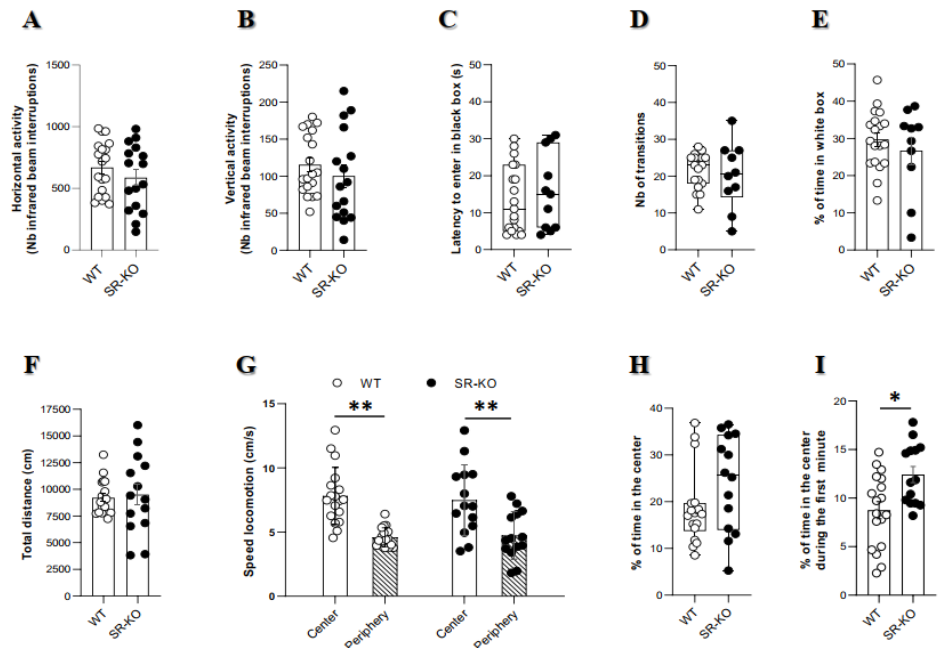
Figure 1. Spontaneous locomotion and anxiety-related behaviors are not consistently impacted by serine racemase (SR) deletion. ( A , B ). Horizontal ( A ) and vertical ( B ) activities in the actimeter between wildtype (WT) ( n = 19) and SR-knockout (SR-KO) ( n = 16) mice indicating una ff ected general locomotor activity (unpaired t test with Welch’s correction). ( C – E ). Latency for first entry into the black box ( C ), number of transitions between black and white boxes ( D ) percentage of time spent in the white compartment, ( E ) in the black and white box of WT ( n = 19) and SR-KO ( n = 11) mice (unpaired t test with Welch’s correction for the latency and the percentage of time, Mann–Whitney test for the number of transitions). ( F – I ). Total distance traveled ( F ), speed locomotion in the center and the periphery ( G ), and percentage of time spent in the center during the 30 min period ( H ) or during the first one minute ( I ) in the open-field test of WT ( n = 18) and, SR-KO ( n = 14) mice. Except for a significant increase in the percentage of time in the center during the first minute, no behavioral changes were noted (* p < 0.05 for unpaired t test with Welch’s correction for the total distance and the percentage of time in the center in the first time, ** p < 0.001 for two-way ANOVA for the speed locomotion, Mann–Whitney test for the percentage of time in the center during all time of test).